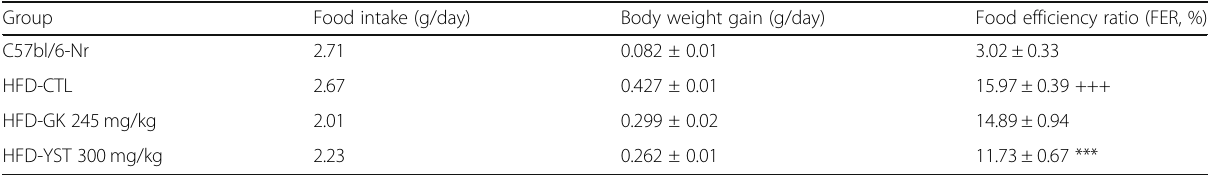
Table 2 Food intake, body weight gain, and food efficiency ratio Group Food intake (g/day)